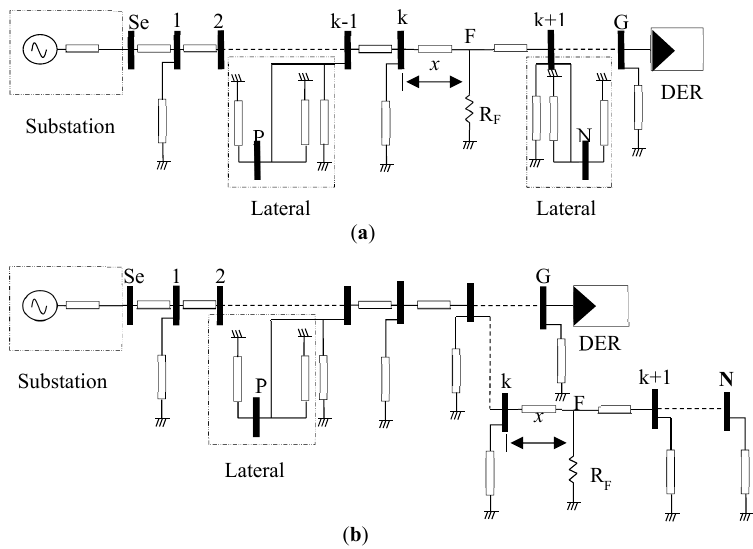
Figure 8. Analysis conditions to calculate the fault current: ( a ) analysis of a fault upstream of the DER and ( b ) analysis of a fault downstream of the DER.